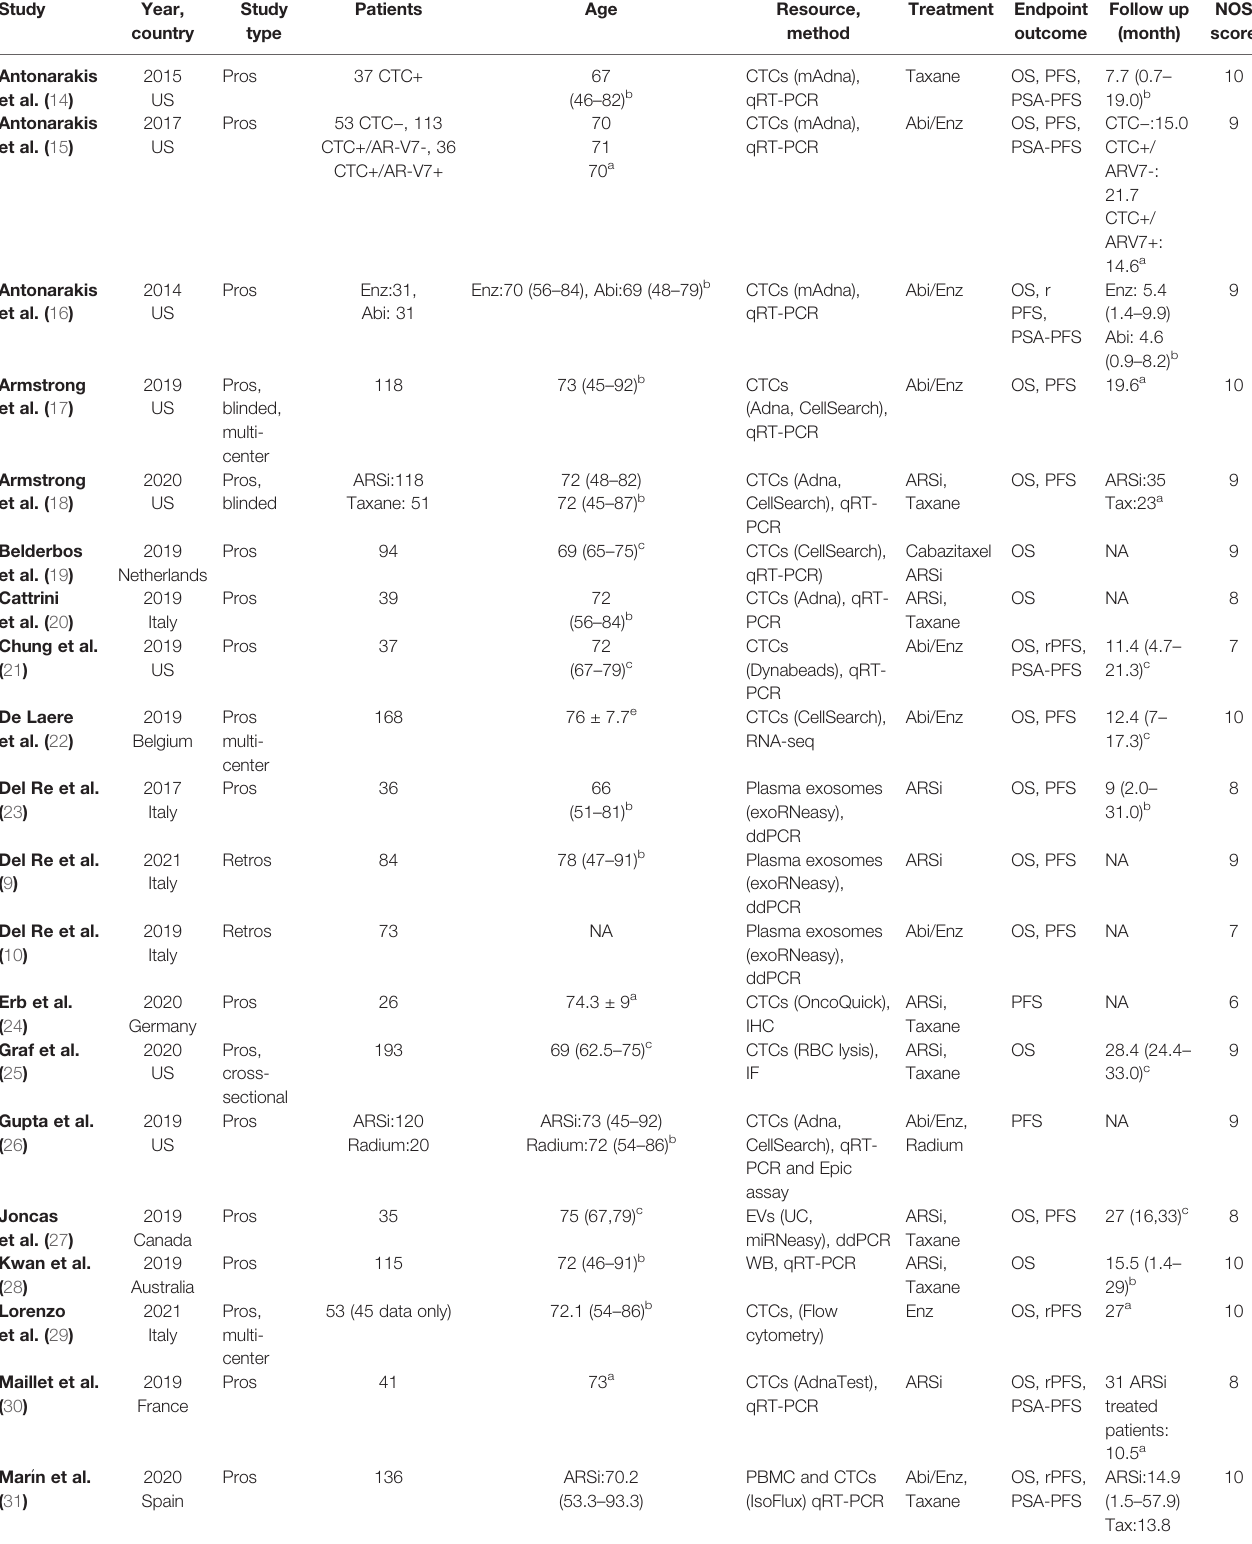
TABLE 1 | The basic characteristics of eligible